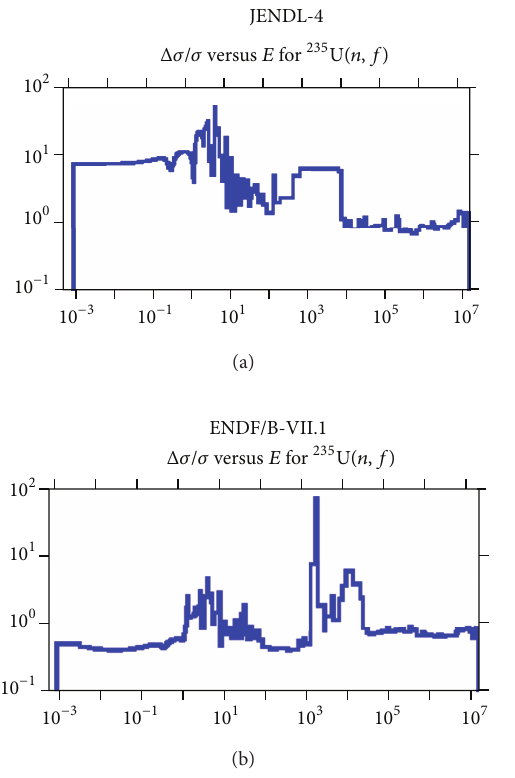
F 15: 172 groups relative variances computed with ERRORJ for the cross-section.